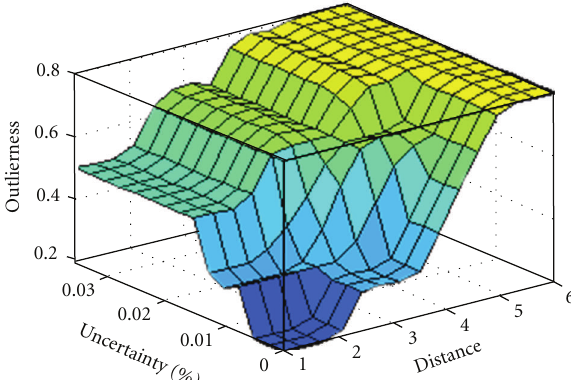
Figure 2: Plot of the inference rules e ff